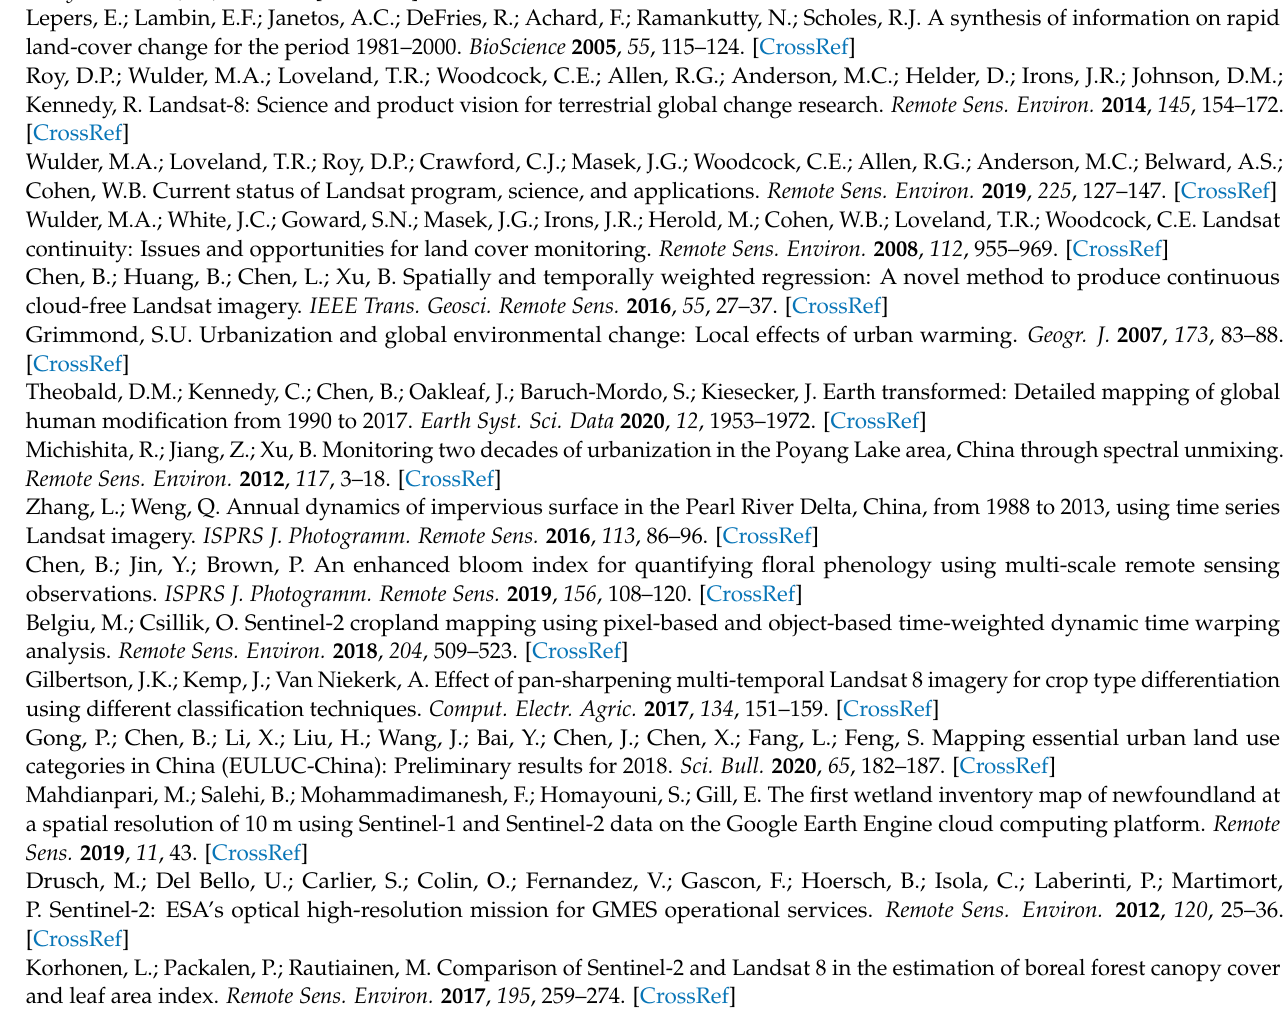
are shown as the zoomed-in comparison of (m-r). Figure S2. Super-resolution results using NAIP imagery. The reference high-resolution images from NAIP-0.6m are shown on the left. On the right are zoomed-in subsets of the yellow box from original reference, bicubic interpolation, Non-GAN derived, and GAN-derived results. Table S1. Comparison of Landsat and Sentinel-2 bandwidth. Table S2. Accuracy assessment of two training scenarios in actual